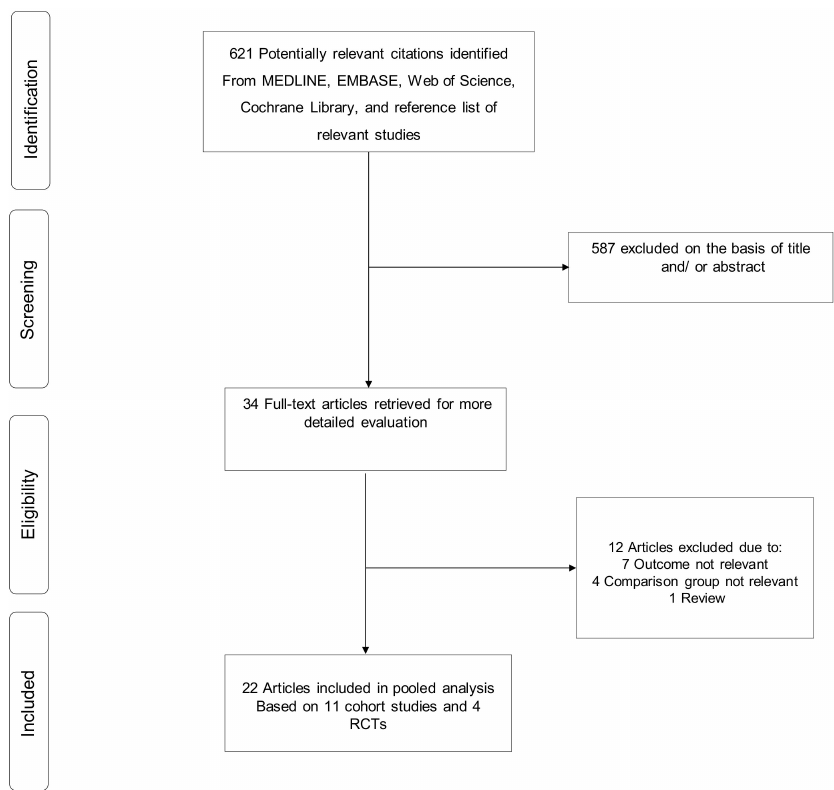
Figure 1. PRISMA flow